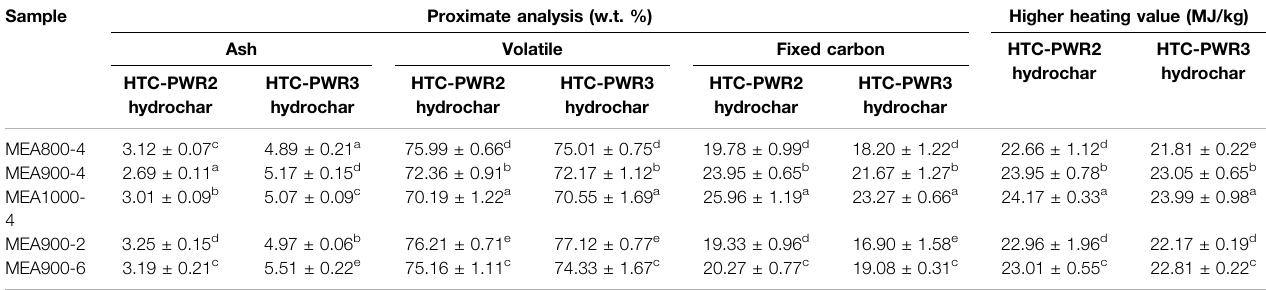
TABLE 5 | The proximate analysis and higher heating value of wheat straw hydrochar after microwave energy activation. Sample Proximate analysis (w.t. %)